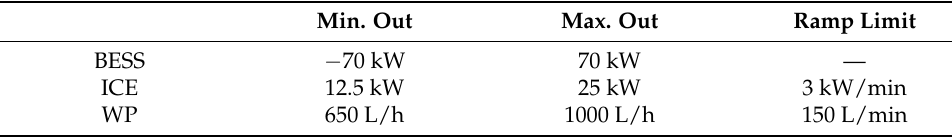
Figure 4. MultiGood MicroGrid Laboratory (MG 2 Lab) single line diagram. Table 1. Technical limits of MG 2 Lab units in this